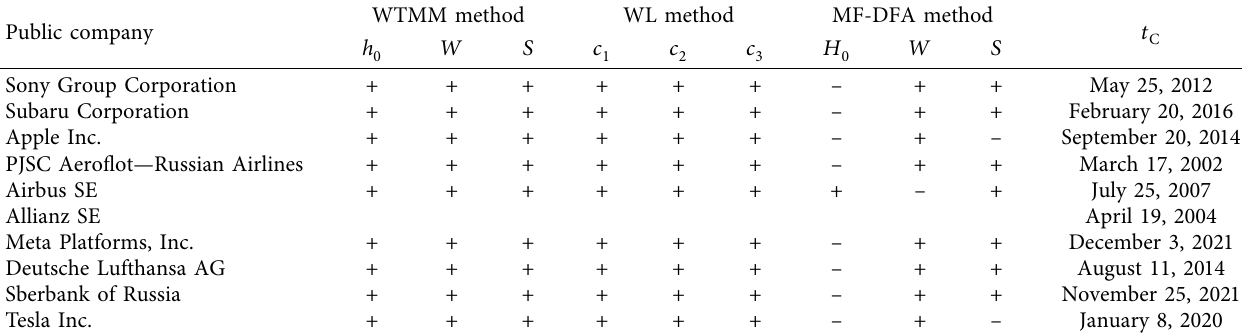
) of the stock exchange C